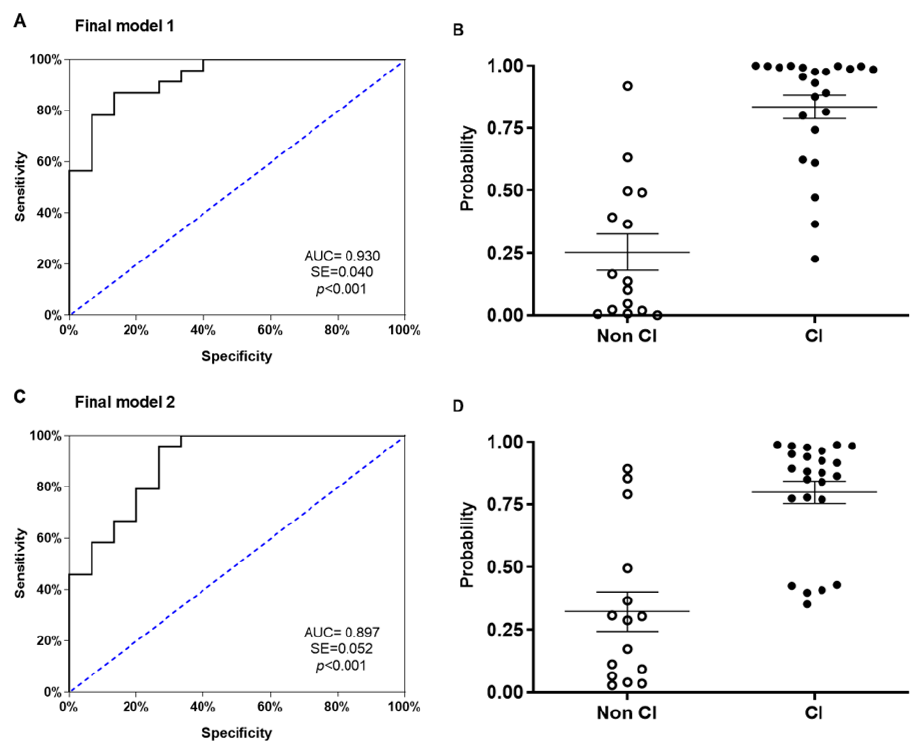
Figure 4. ROC analyses and scatter dots for multivariate predictive of final models of cognitive impairment. ( A ) ROC curve for the final model 1 whose variables were: “age”, “NfL/BDNF ratio”, “age at first alcohol use”, “age at onset of AUD”, and “length of AUD diagnosis”. ( B ) Scatter plot of the predictive probabilities for the final model 1. ( C ) ROC curve for the final model 2 whose variables were: “age” and “NfL/BDNF ratio”. ( D ) Scatter plot of the predictive probabilities for the final model 2. The lines of the scatter plots are means and standard deviations. CI = cognitive impairment. Open circles are patients without cognitive impairment (Non CI), black filled circles represent patients with cognitive impairment (CI).